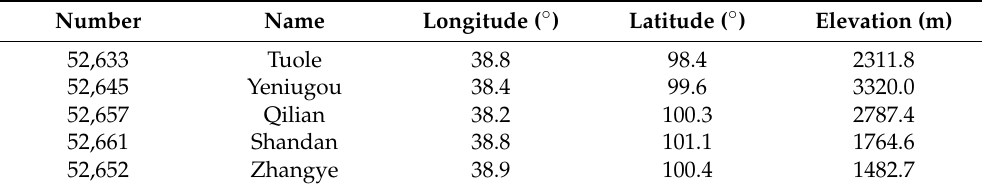
Table 6. Basic information of meteorological stations in the HRB.